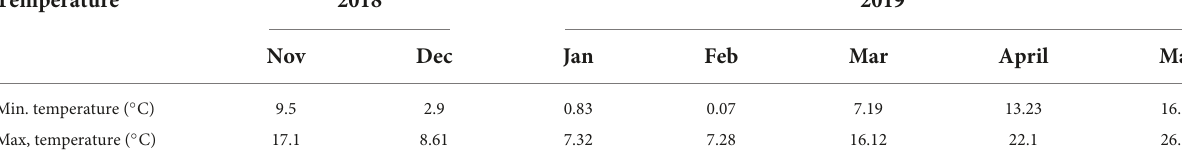
TABLE 1 Average temperatures during growing seasons of 2018–2019.